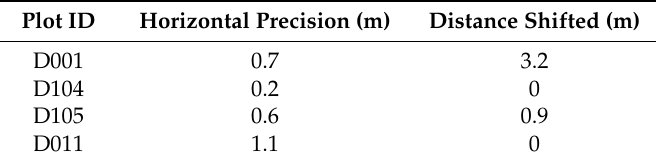
Table A1. Reported plot center precision and distance of plot shift when stem-mapped trees were compared to the LiDAR-derived canopy height model are presented for each